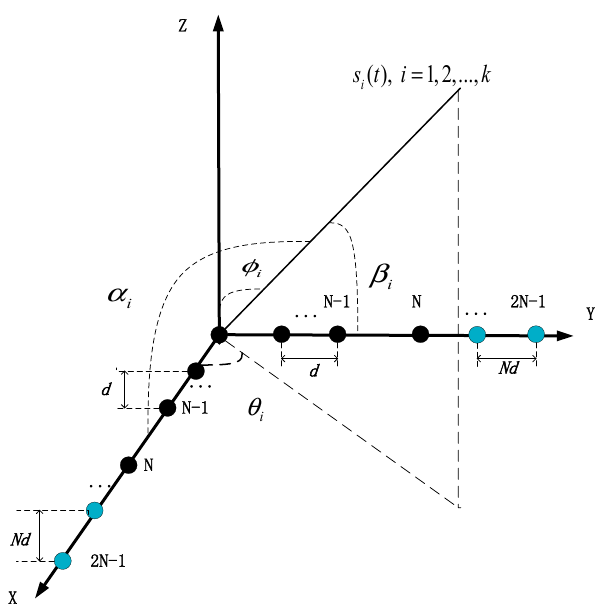
Figure 1. The geometry of the L-shaped nested array. Black dots indicate sensors of inner ULA with inter-spacing d , while blue dots show sensors of outer ULA with inter-spacing Nd .